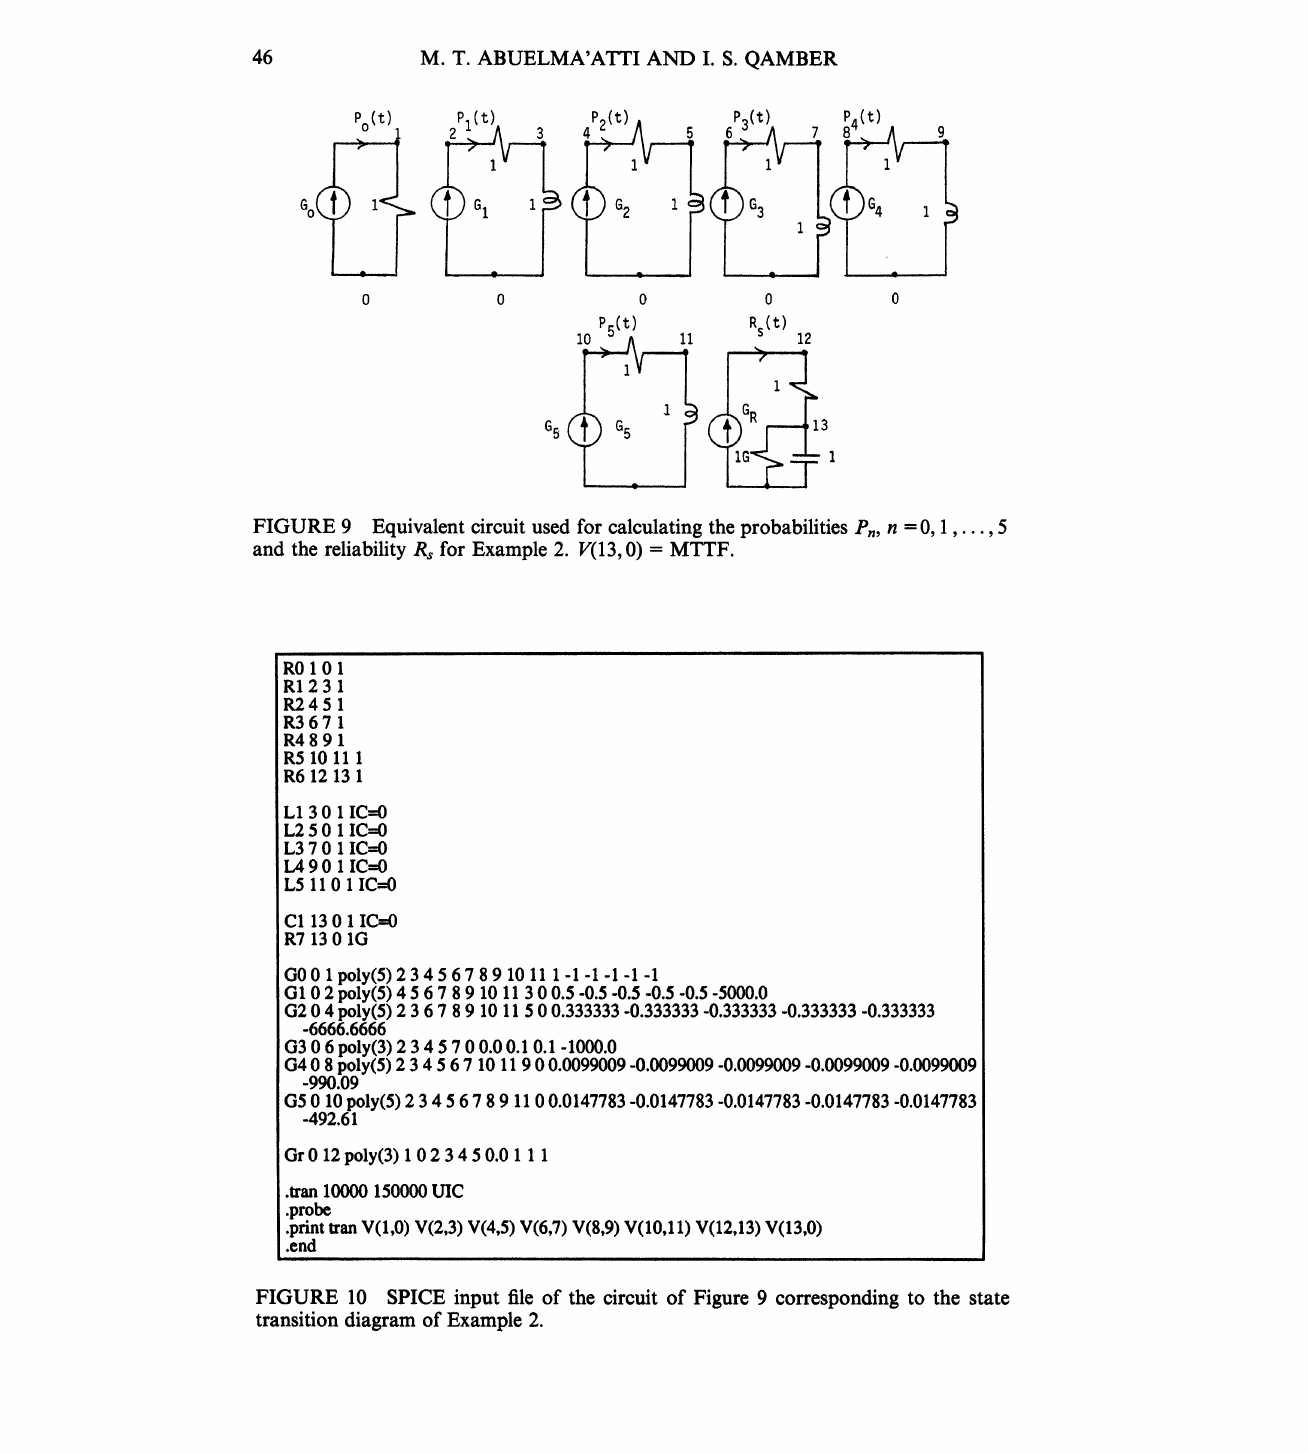
FIGURE 10 SPICE input file of the circuit of Figure 9 corresponding to the state transition diagram of Example